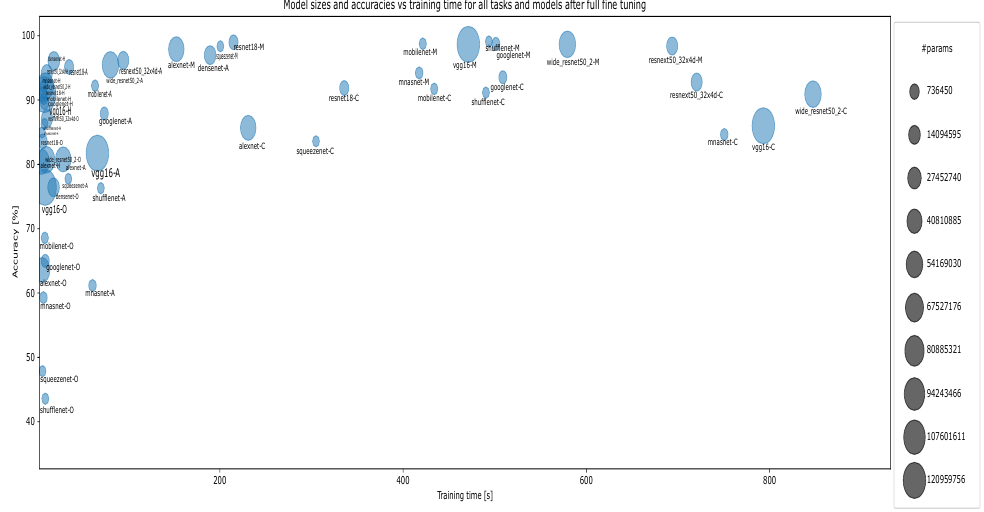
Figure A17. Model sizes and accuracy vs. training time for all tasks and models after full fine-tuning, where A refers to Augmented smartphones, C to CIFAR10, H to Hymenoptera, M to MNIST, and O to the Original smartphone dataset.